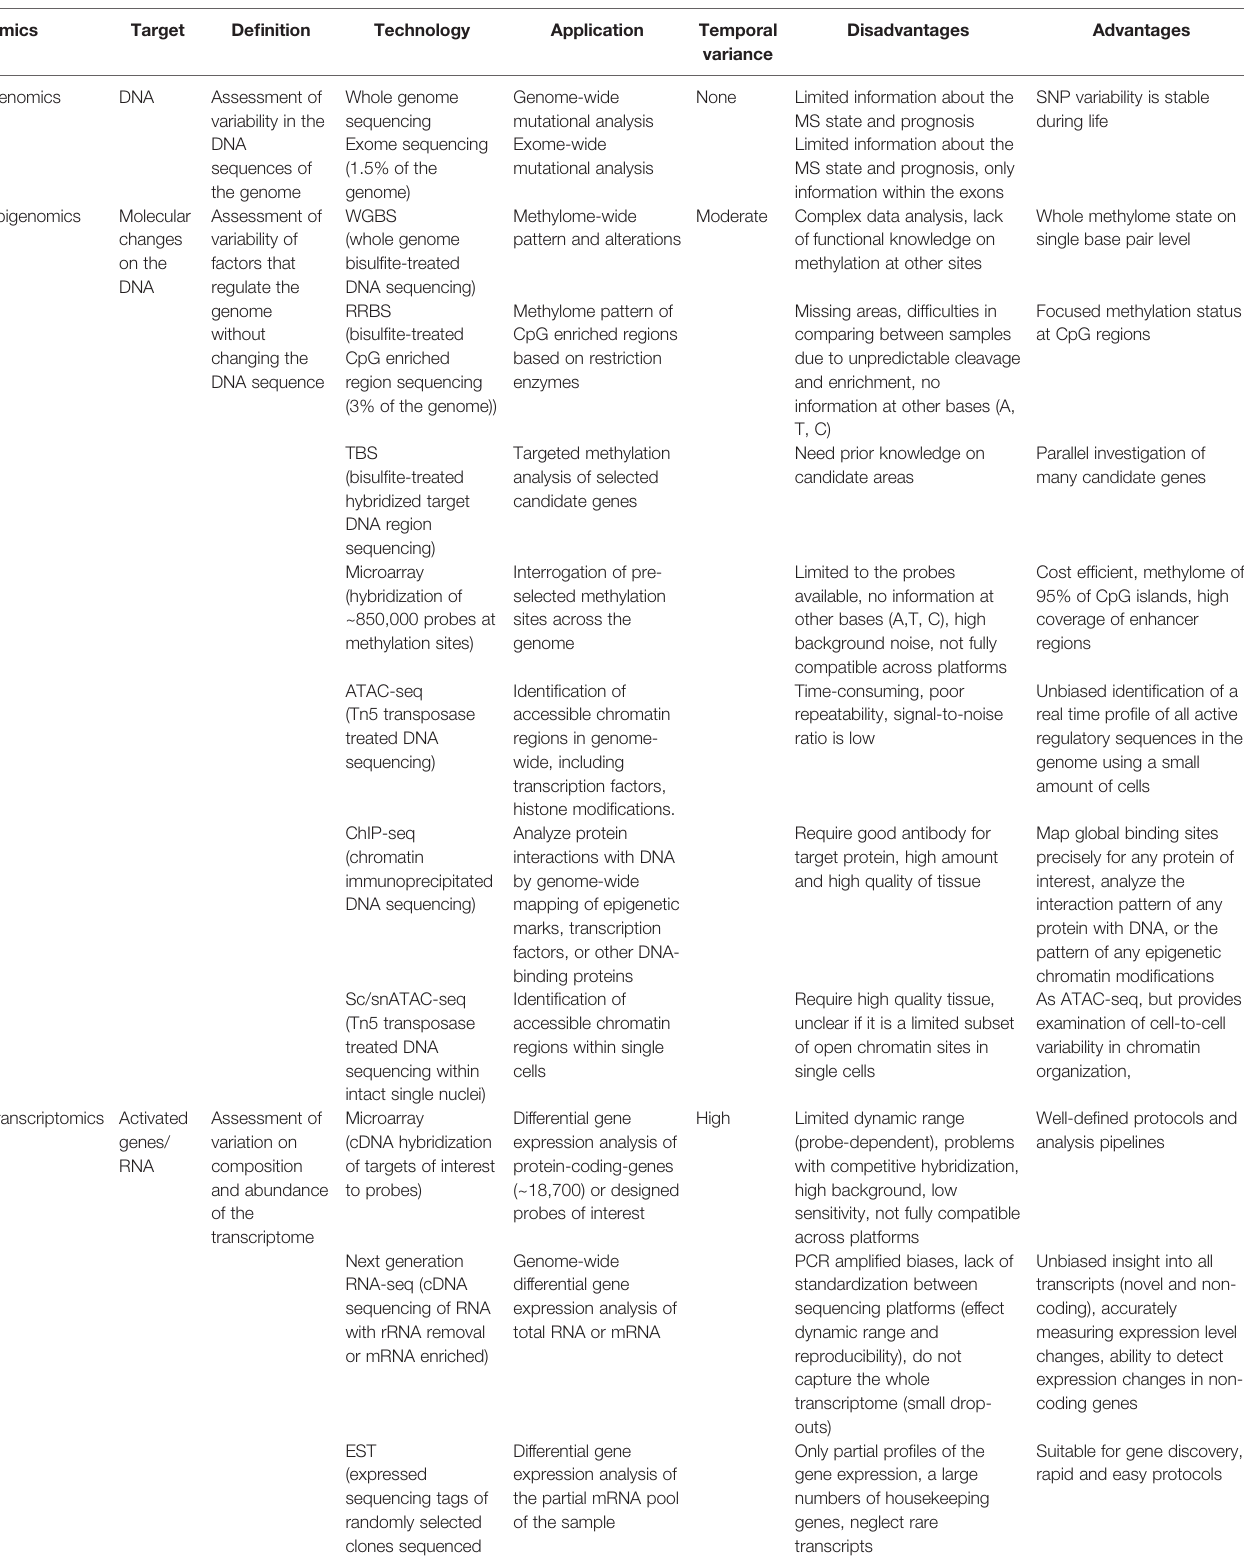
TABLE 1 | An overview of the advantages and disadvantages of the omics